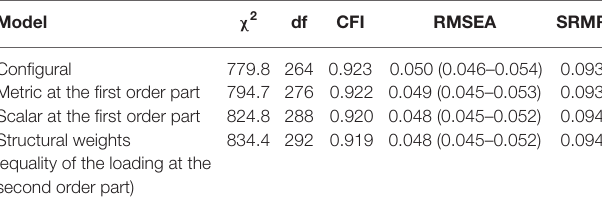
TABLE 3 | Fit indices for measurement invariance